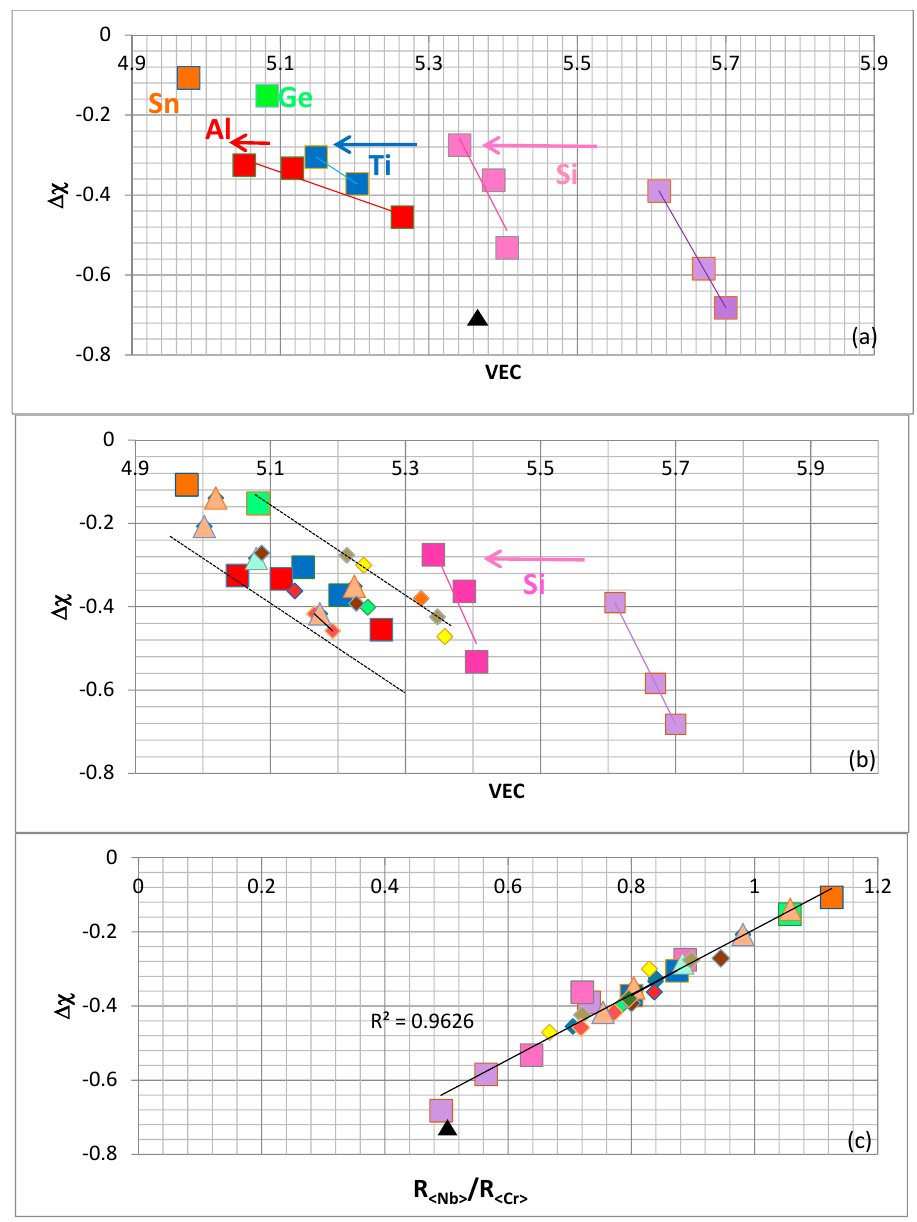
Figure 2. Laves phase ∆χ versus VEC maps are shown in ( a , b ), and ( c ) is the Laves phase ∆χ versus R<Nb>/R<Cr> map. In ( a , b , c ), the squares are data for NbCr 2 (lavender), Nb(Cr,Si) 2 (pink), (Nb,Ti)(Cr,Si) 2 (blue), (Nb,Ti)(Cr,Si,Al) 2 (red), (Nb,Ti)(Cr,Si,Ge) 2 (green) and (Nb,Ti)(Cr,Si,Sn) 2 (dark orange). In ( b , c ) the triangles are data for (Nb,Ti)(Cr,Si,Al,Sn) 2 and (Nb,Ti,Mo,Hf)(Cr,Si,Al,Sn) 2 (light orange), and (Nb,Ti)(Cr,Si,Al,Ge) 2 (light green); the diamonds are data for (Nb,Mo)(Cr,Si,Al) 2 (yellow), (Nb,Ti,Ta)(Cr,Si,Al) 2 , (Nb,Ti,Hf)(Cr,Si,Al) 2 , (Nb,Ti,Mo,Hf)(Cr,Si,Al) 2 (red), (Nb,Ti,Hf)(Cr,Si,Ge) 2 (light green), (Nb,Hf)(Cr,Si,Sn) 2 and (Nb,Ti,Hf)(Cr,Si,Sn) 2 (dark orange), (Nb,Ti,Mo,W,Hf)(Cr,Si,Sn) 2 (brown). In ( a – c ) the black triangle represents the Nb–55Cr–15Si Laves phase.